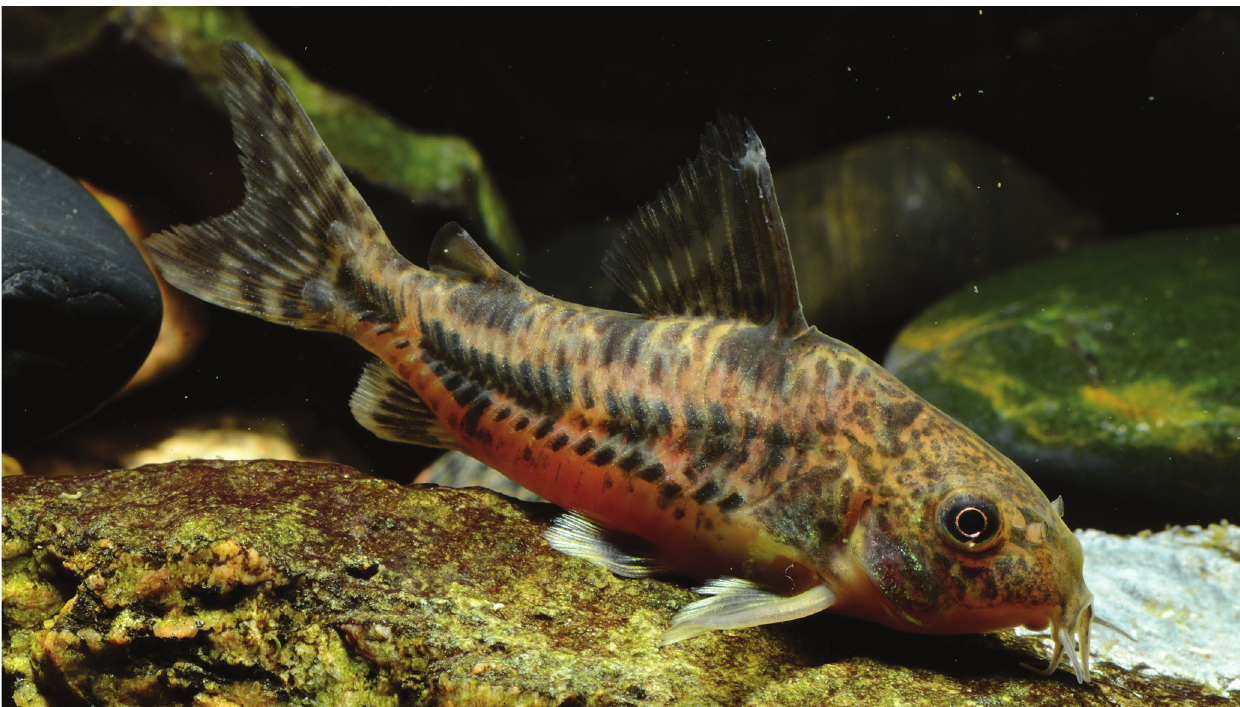
Fig. 5. Uncatalogued live specimen of Corydoras paleatus with approximately 43.0 mm SL, from the Laguna del Diario, Maldonado, Uruguay. Photo by Hans-Georg